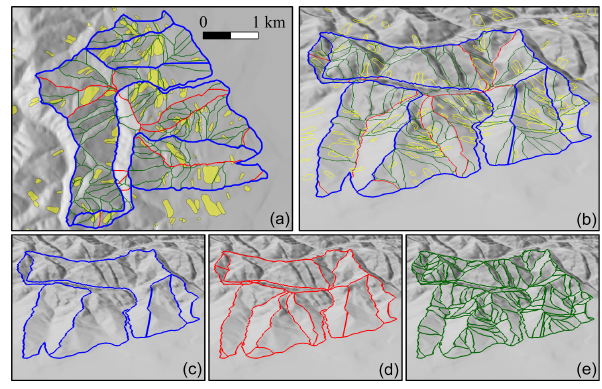
Figure 7. Example of subdivisions into SUs for a portion of the study area. Legend: blue, red, and green lines show boundaries of SUs of increasing density and corresponding decreasing average size. Yellow areas are landslides. The five maps show the same area in plan view (a) and in perspective view (b, c, d, e)